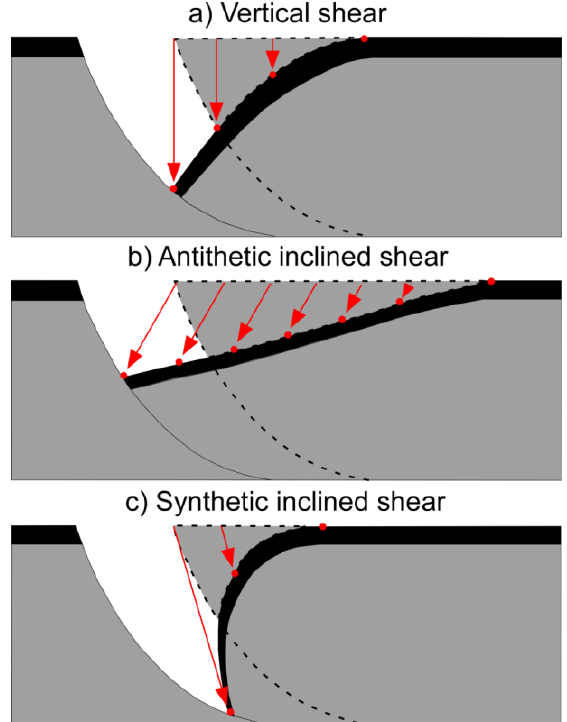
Figure 2. Illustration of the technique of ( a ) vertical simple shear, ( b ) antithetic inclined simple shear and ( c ) synthetic inclined simple shear. Antithetic simple shear results in a broader basin compared to for instance synthetic shear. Modified after Fossen [41].